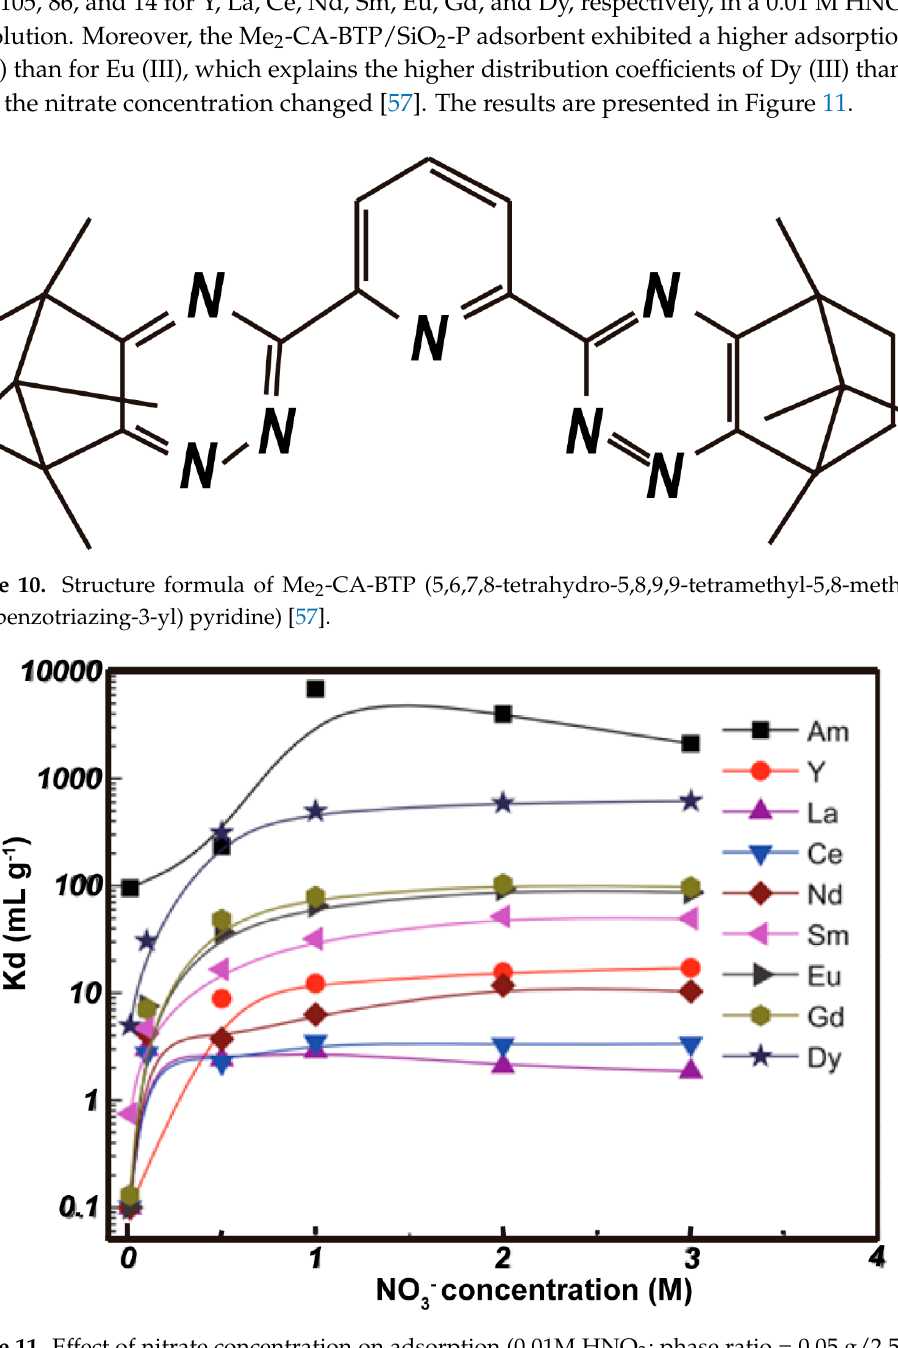
Figure 11. Effect of nitrate concentration on adsorption (0.01M HNO 3 ; phase ratio = 0.05 g/2.5 mL; 241 Am (III) = 1000 Bq/mL; Ln (III) = 1 mM; temperature = 298 K; contact time = 24 h; and sharking speed = 120 r/min)